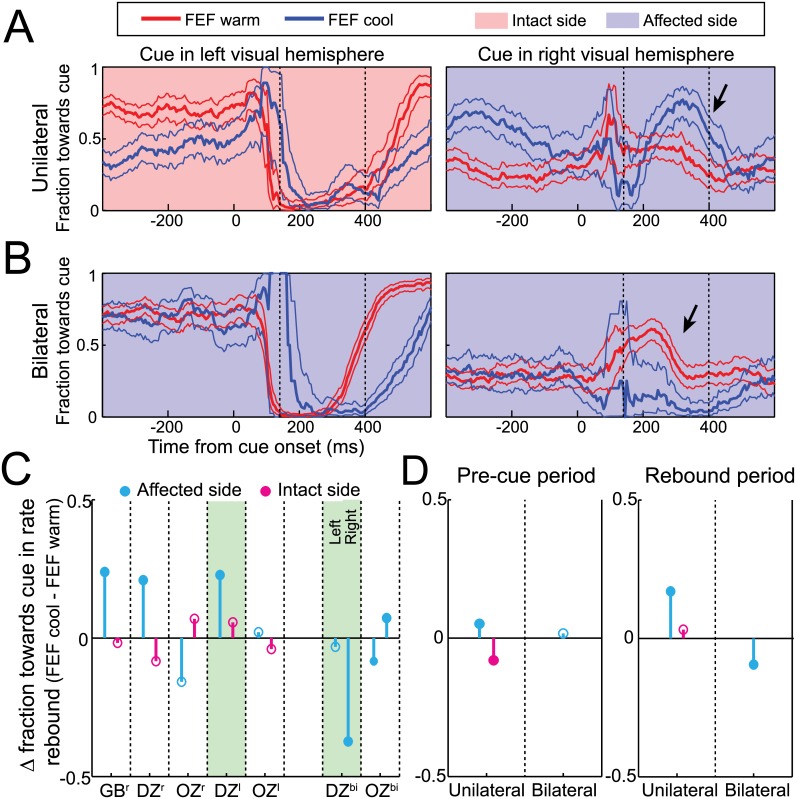
Unilateral FEF inactivation biased microsaccades toward the affected side, whereas bilateral FEF inactivation rescued this effect and delayed and magnified any pre-existing cue-induced directional modulations.(A) Time courses of mean microsaccade directionality (i.e., fraction toward cue +/- 95% confidence intervals) in response to cues either in the affected or intact visual hemifield for unilateral FEF warm and FEF cool conditions from our example monkey DZ. While unilateral FEF inactivation biased microsaccades towards the affected field before cue onset, a change in post-cue microsaccades only accompanied cues for the affected visual hemifield (see arrow). (B) Bilateral FEF inactivation did not bias microsaccades in the pre-cue period but delayed and magnified the pre-existing directional biases in the microsaccadic inhibition and rebound periods (see arrow). (C) Three of five unilateral FEF inactivation configurations had similar effects, whereas bilateral FEF inactivation in both monkeys produced no pre-cue directional bias, and a magnification of pre-existing biases in the rebound period. (D) A pre-cue bias toward the affected side was consistent across monkeys only with unilateral FEF inactivation, whereas unilateral and bilateral FEF inactivation impacted cue-induced microsaccade directionality following cues in the affected side. Same format as Fig 2C. Data in Supporting Information (see S6 Data).